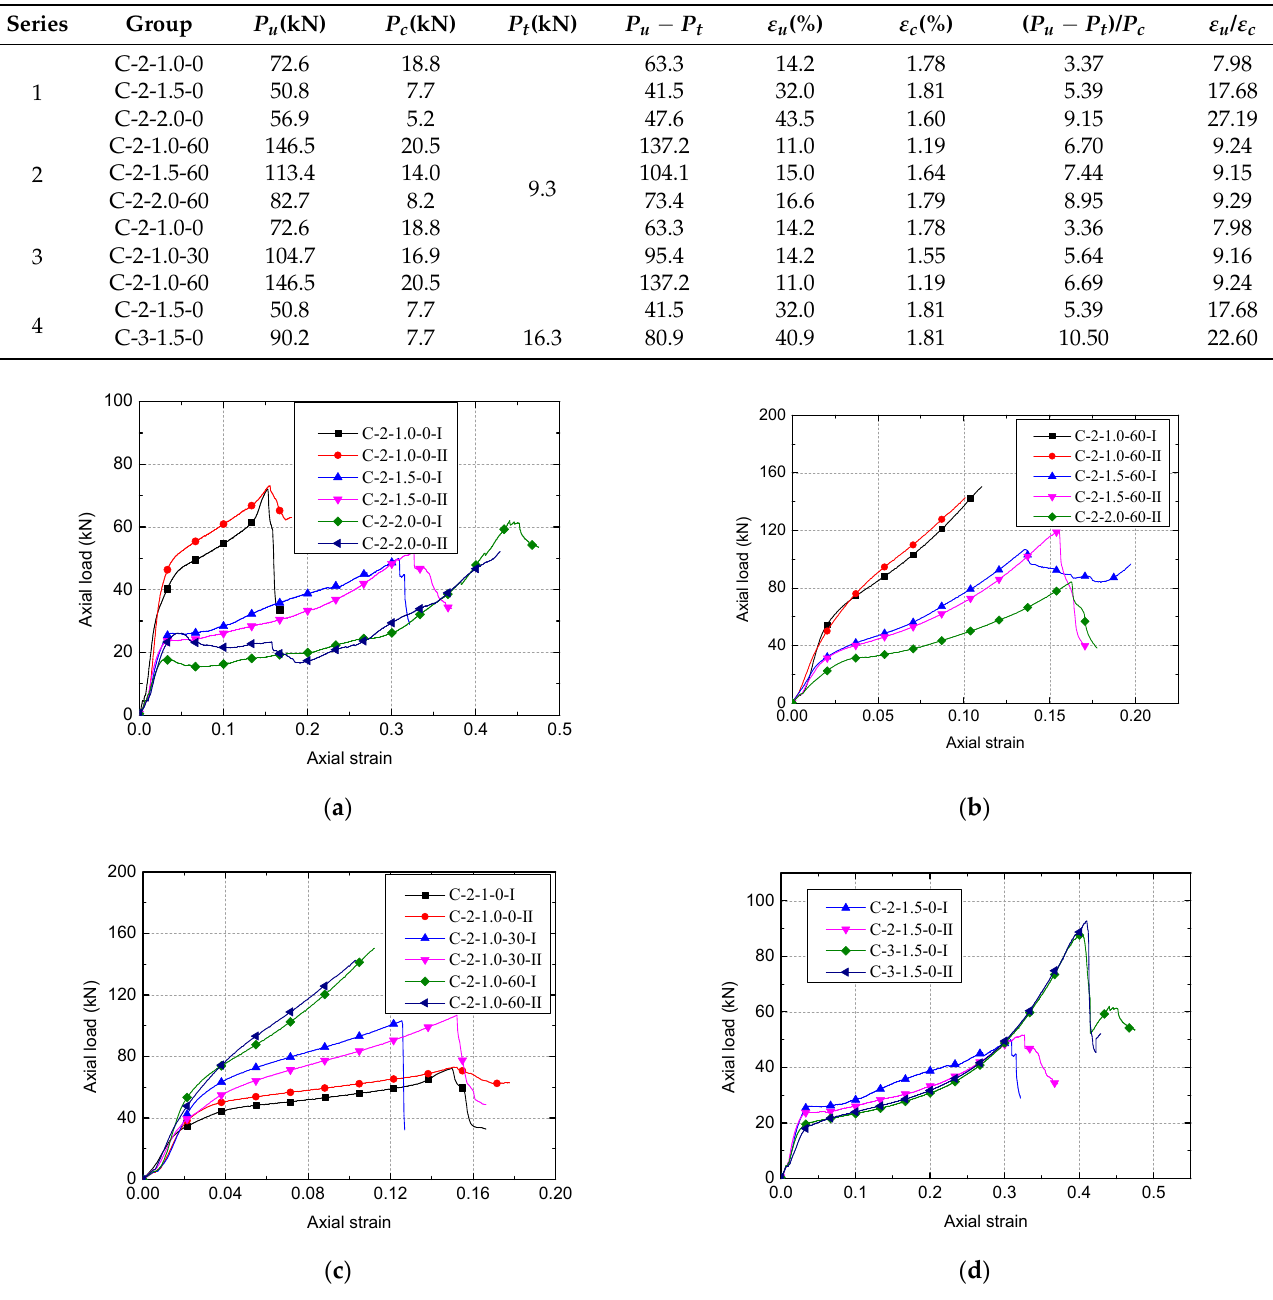
Figure 9. Load–strain curve of CSBM specimens: ( a ) Series 1; ( b ) Series 2; ( c ) Series 3; ( d ) Series 4.